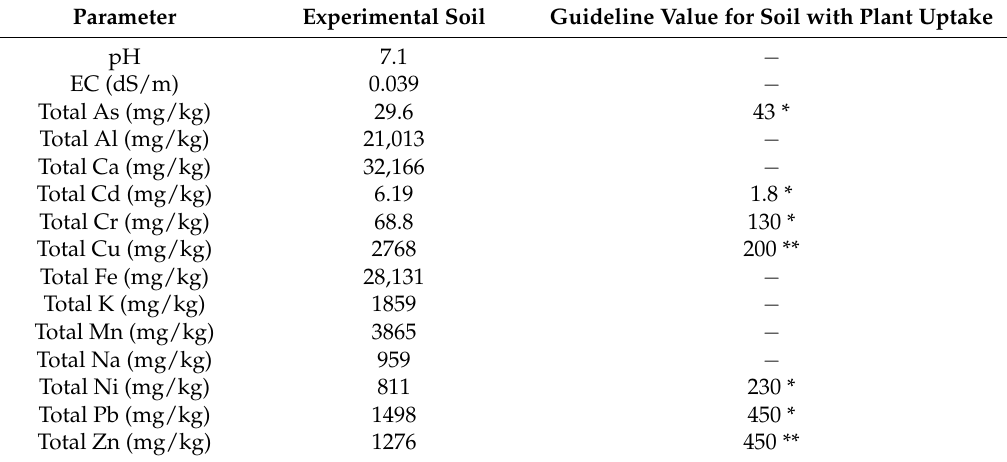
Table 1. Major physical and chemical characteristics of the soil materials used in this study.